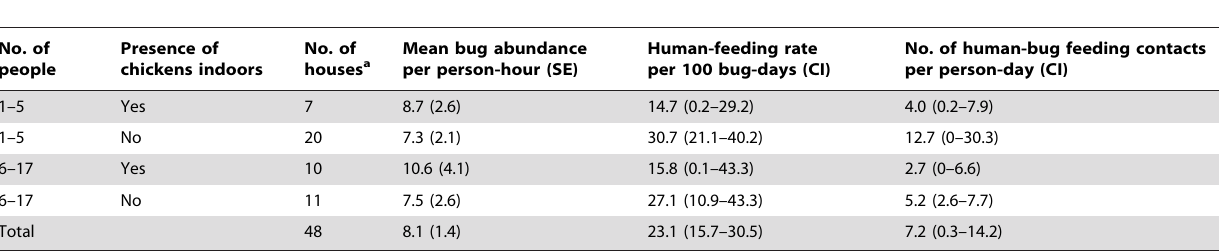
Table 2. Human-feeding rate per 100 bug-days and number of human-bug feeding contacts per person-day of late-stage domestic T. infestans according to presence of chickens indoors and numbers of resident people (Figueroa, spring 2003).